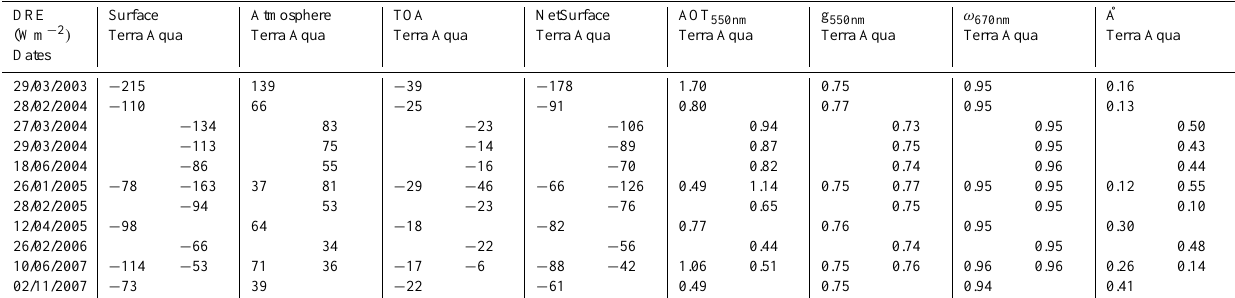
Table 3. Characteristic dates of dust events and corresponding DRE (Wm − 2 ) at the surface, within the atmosphere, at TOA and net surface, AOT and g at 550nm, ω at 670nm and Angstrom coefficient. DRE (Wm − 2 )